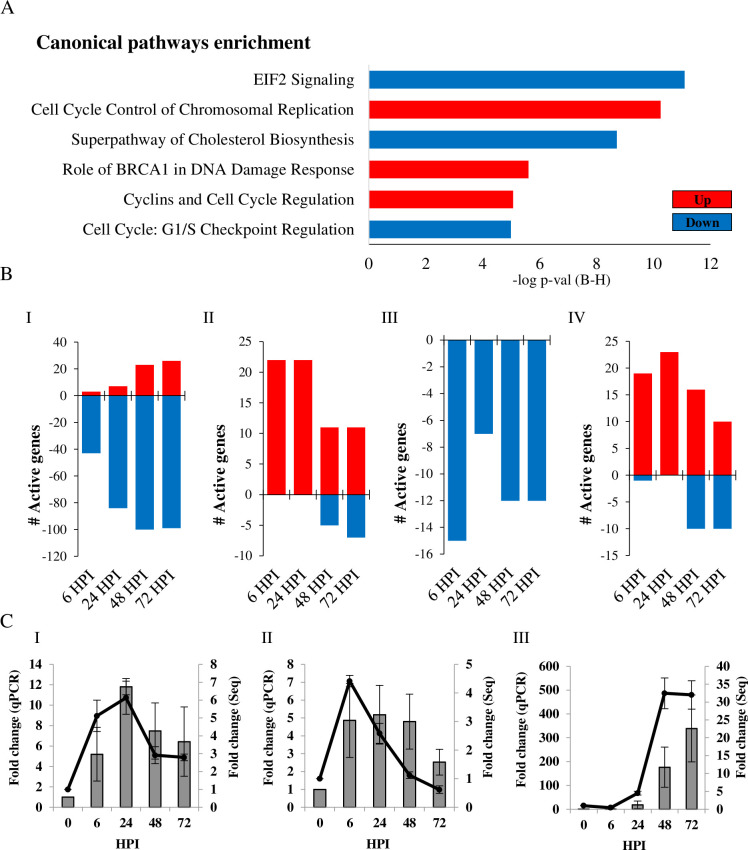
Analysis of canonical pathways in HCoV-229E-infected cells.(A) Canonical pathways enrichment analysis. Analysis was conducted for HCoV-229E-infected MRC-5 cells at 6 hours post-infection (HPI) as compared to uninfected cells. Canonical pathways with highest -log p-value (using Benjamini-Hochberg correction) are presented. (B) The number of activated genes was calculated for the eIF2 (I), cell cycle control of chromosomal replication (II), cholesterol biosynthesis (III) and role of BRCA1 in DNA damage response (IV) pathways. Up- and downregulated pathways are presented in red and blue, respectively. (C) Validation of gene expression. Cells were infected with HCoV-229E and total RNA was extracted and treated as described in the Methods section. Relative gene expression was calculated for ORC1 (I), CDK1 (II) mRNA (belong to cell cycle control of chromosomal replication pathway) and ATF3 (III) mRNA (belongs to eIF2 pathway). Fold-change in transcripts levels, as measured by qPCR analysis (Bars, left Y axis), was compared to the results of the NGS analysis (line, right Y axis).